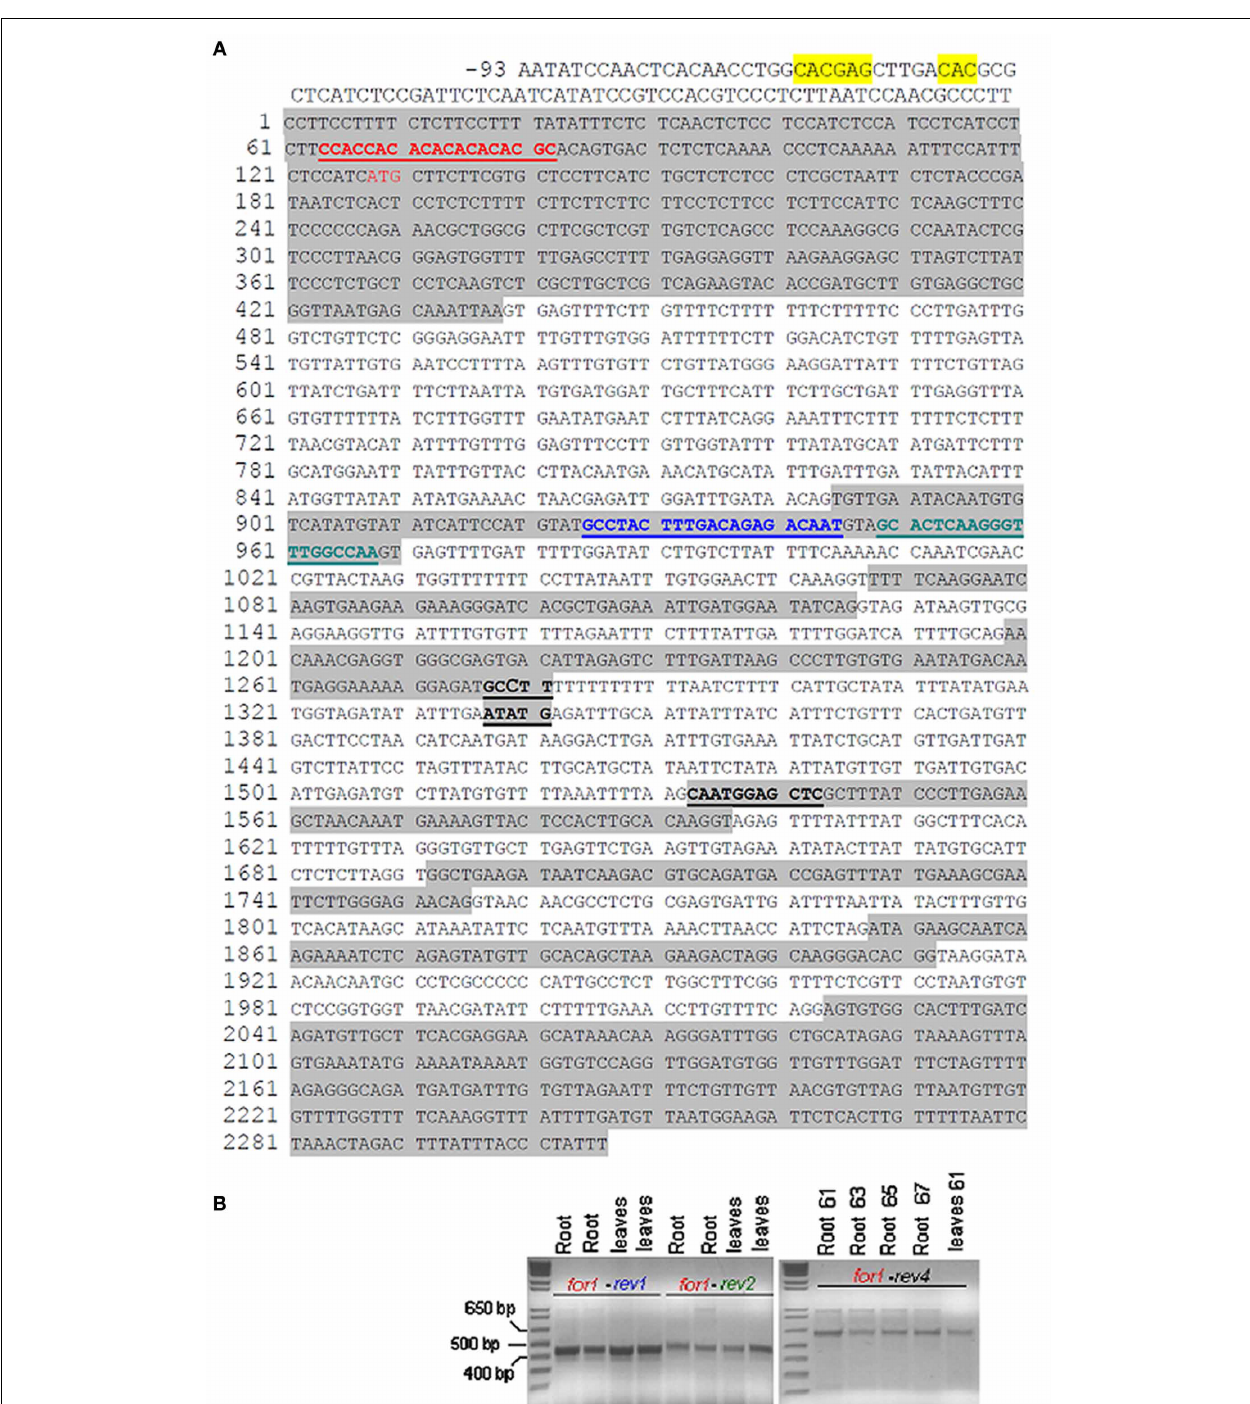
FIGURE 5 | Gene and predicted coding sequence of cucumber ferritin protein XP004163524 (reported at NCBI as ferritin-3, chloroplastic-like, transcript variant 1, LOC101221012). (A) IDRS-like sequence in gene promoter is highlighted in yellow; ATG start is in red color; exons are highlighted in gray. Positions of primers Cucsafor1 (in red), Cucsarev1 (in blue), Cucsarev2 (in green), Cucsarev4 (in black) are underlined; (B) left panel: RT-PCR reactions with primer pairs Cucsafor1-Cucsa-rev1 and